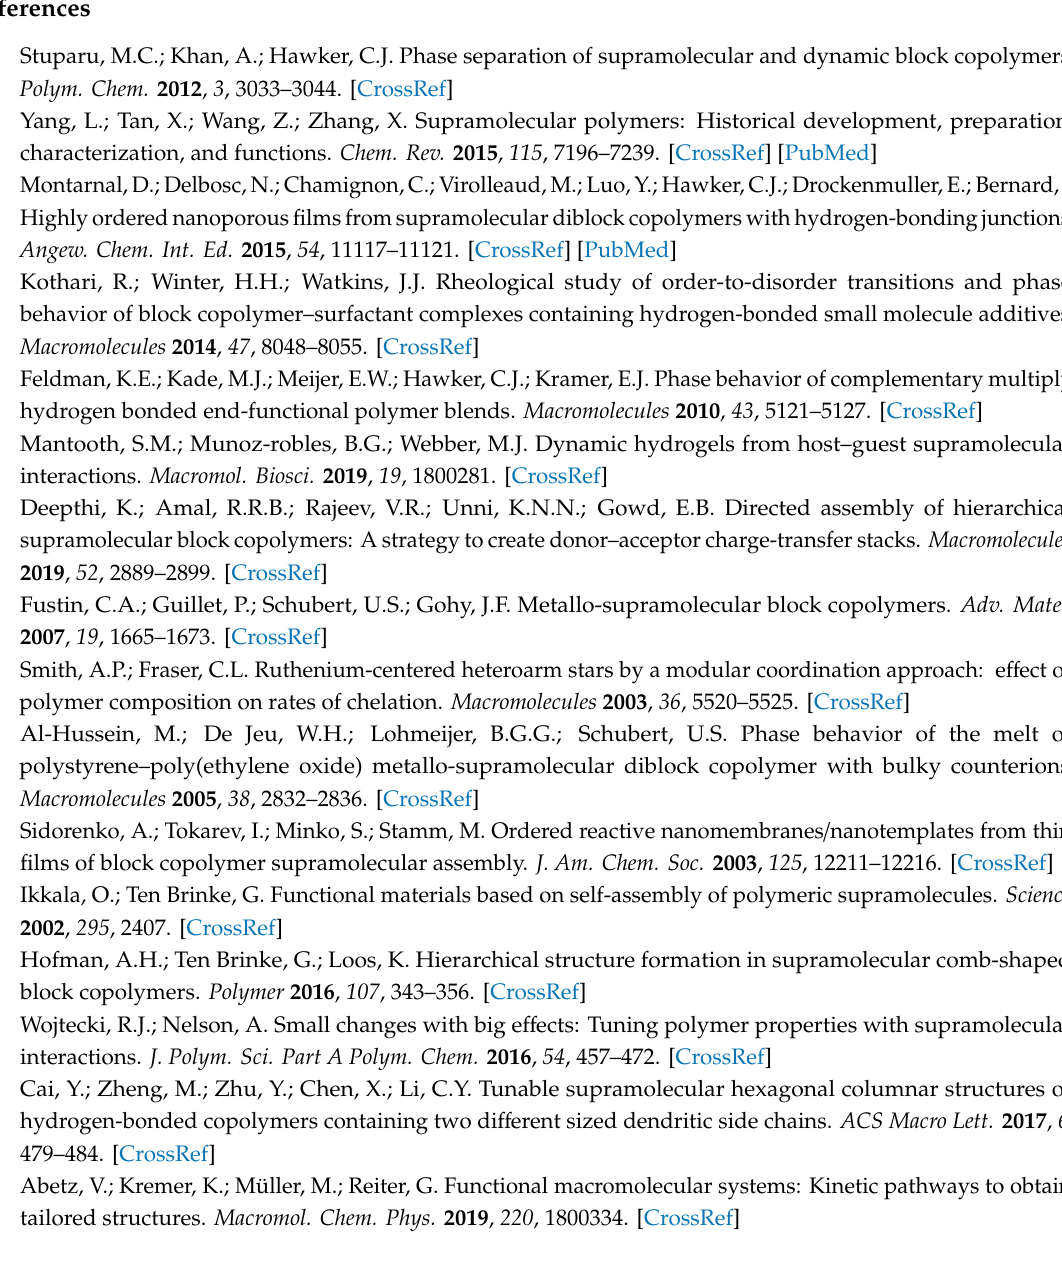
Figure S1: Reaction scheme, Figure S2: Flowchart of the reversible reaction process. Figure S3: Snapshots of A5B5 SDC systems with h = 5.5 and Figure S4: Snapshots of A3B7 SDC systems with h =